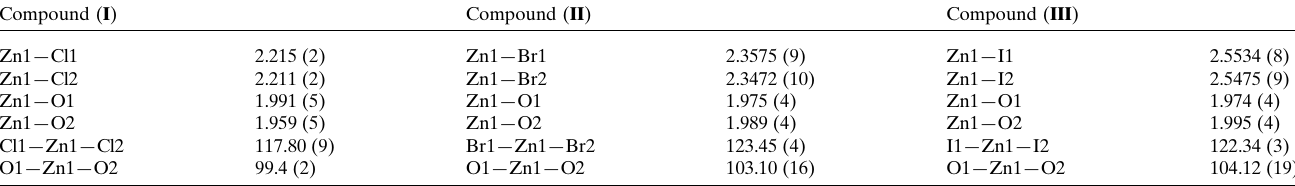
Table 1 Selected bond lengths and angles (A˚ , (cid:2) ).